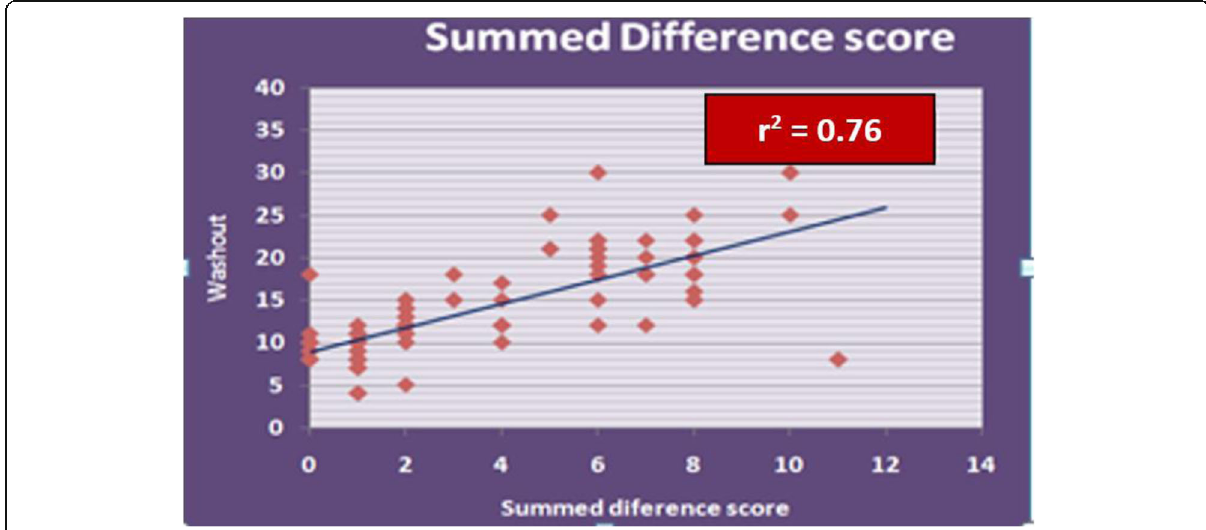
Fig. 6 GWR correlation with SDS